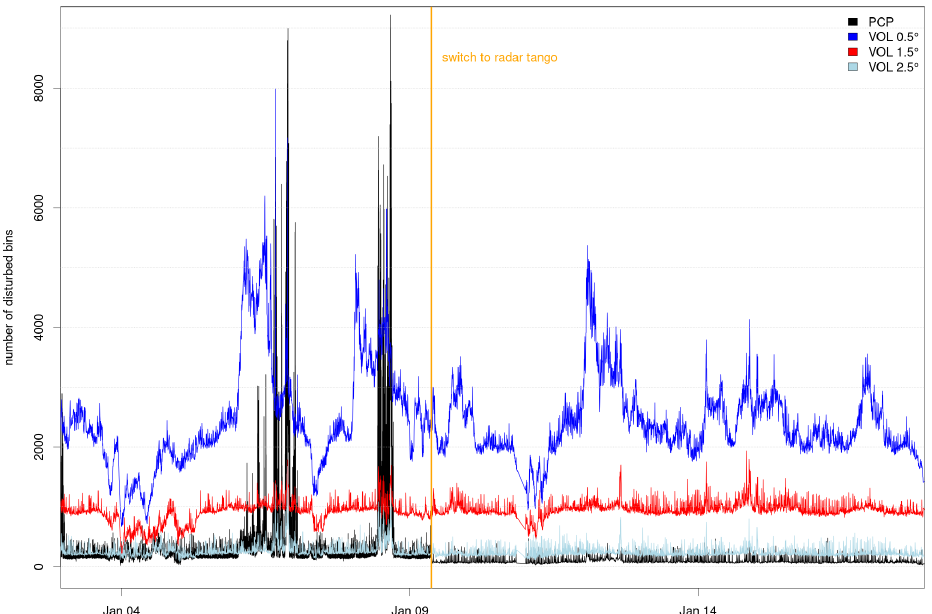
Figure 9. Time series of interference bins in the MHP PCP scan and the lowest three elevations of the VOL scan. The orange line marks the beginning to the Radar Tango.